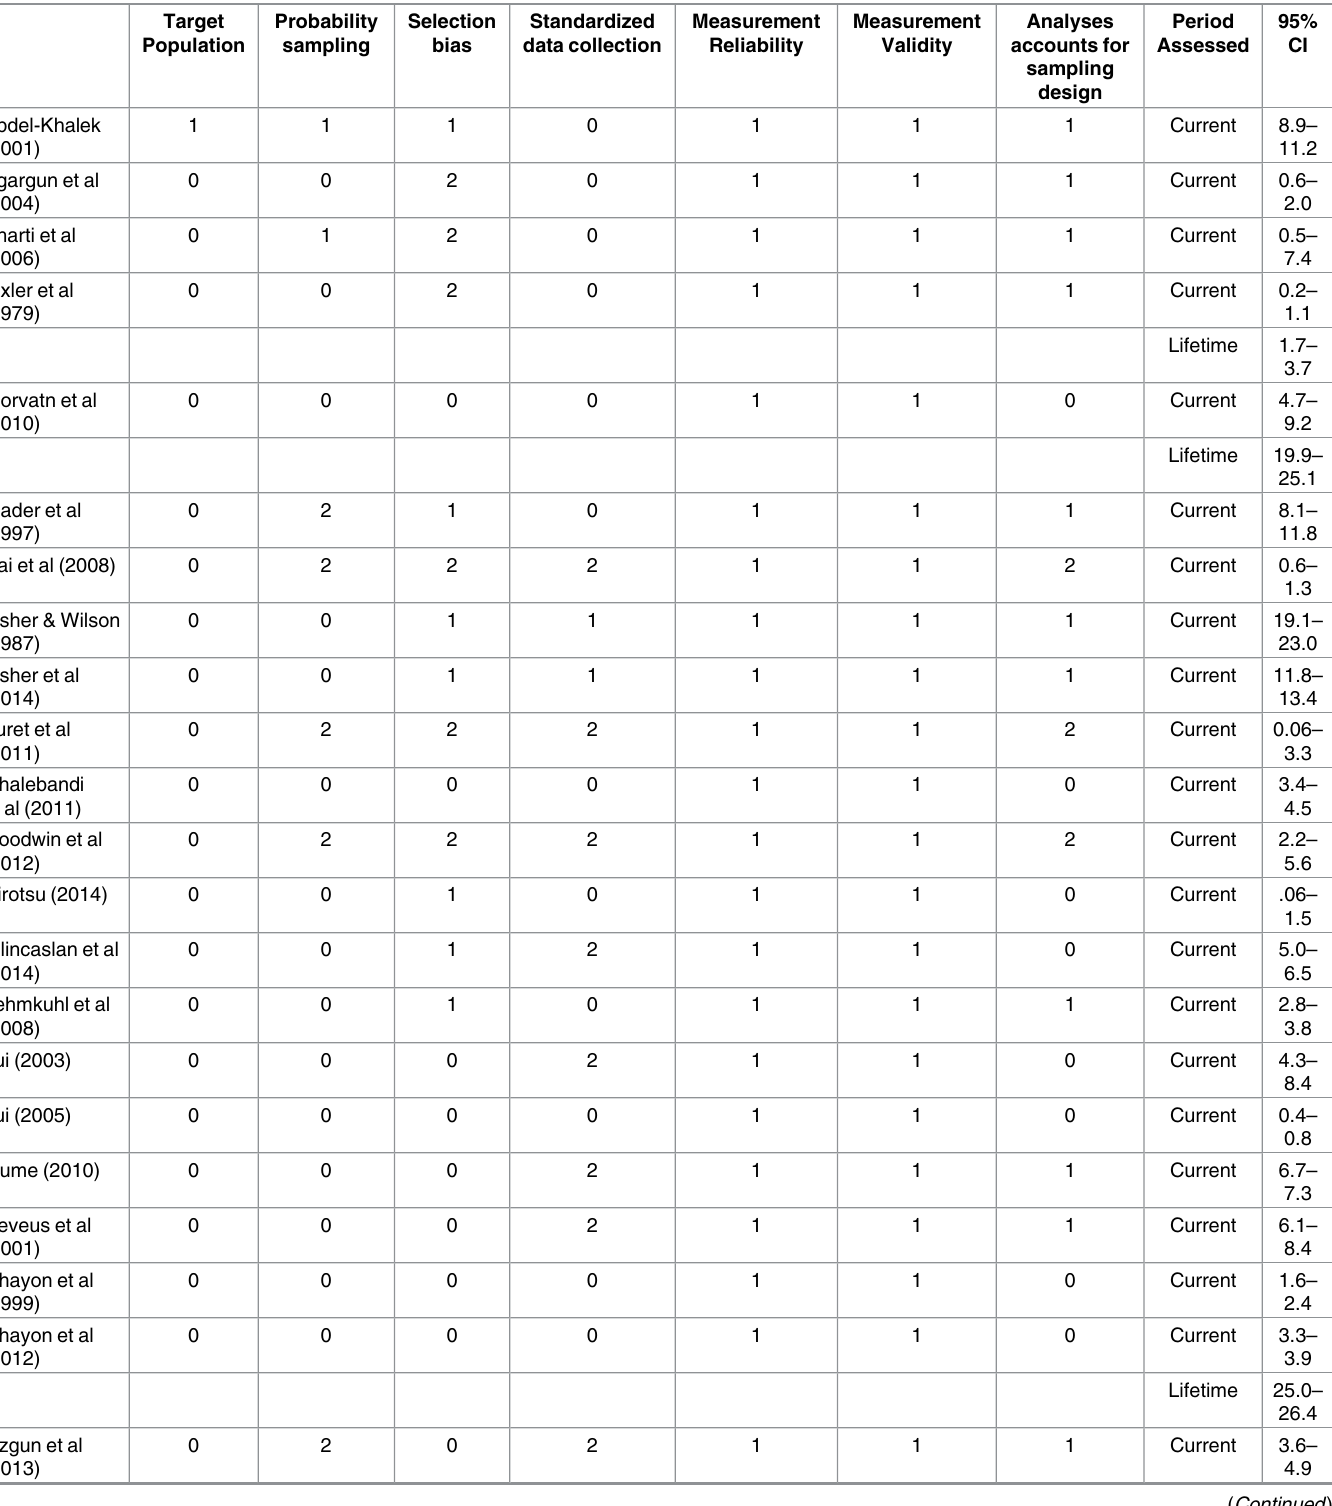
Table 3. Summaryof Risk of Bias in Included